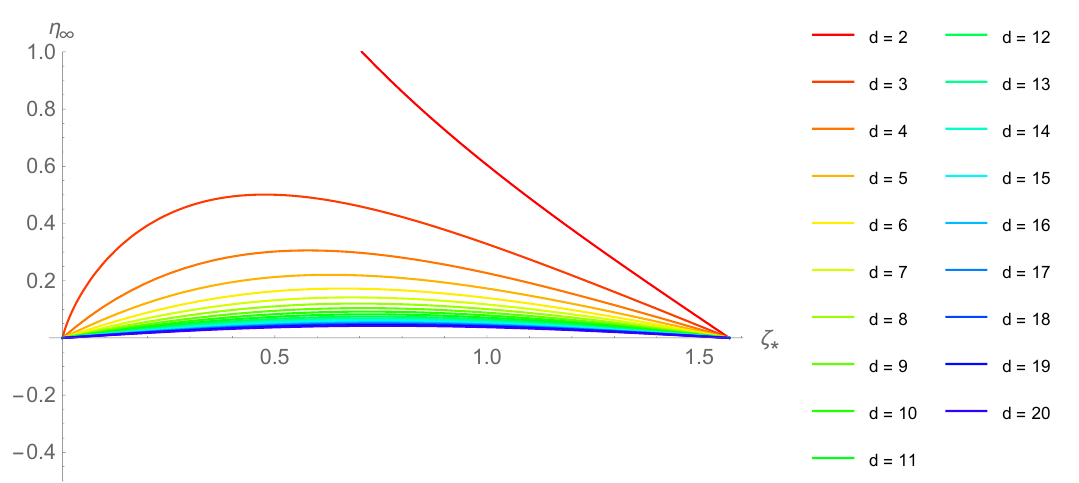
Figure 7 . The boundary condition (cid:17) 1 as a function of the turning point (cid:16) (cid:3) for extremal tube-like surfaces in dimensions d = 2 through d = 20 : While there is no maximal value of (cid:17) 1 for d = 2, there exists a maximal (cid:17) 1 in d > 2 | above this value of (cid:17) 1 , extremal tube-like surfaces do